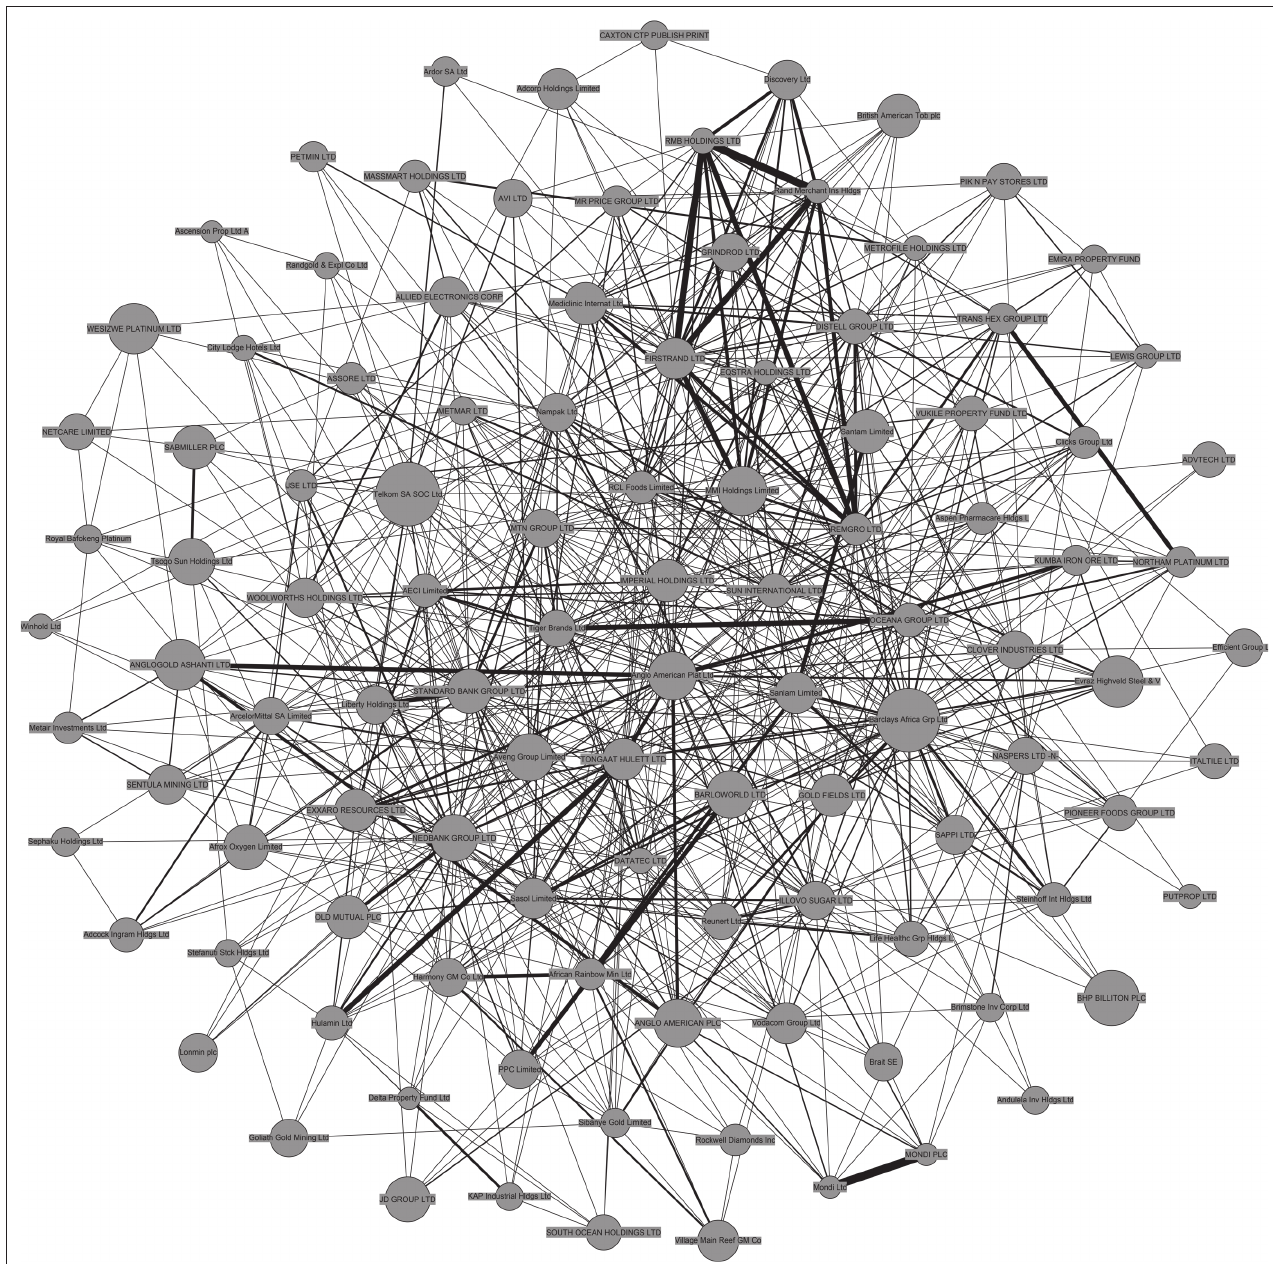
FIGURE 3: The network of companies with direct links to the four banks. TABLE 3: Companies with ties with three and four of the major four banks. Company Rank of betweenness Rank of closeness Rank of degree Rank of